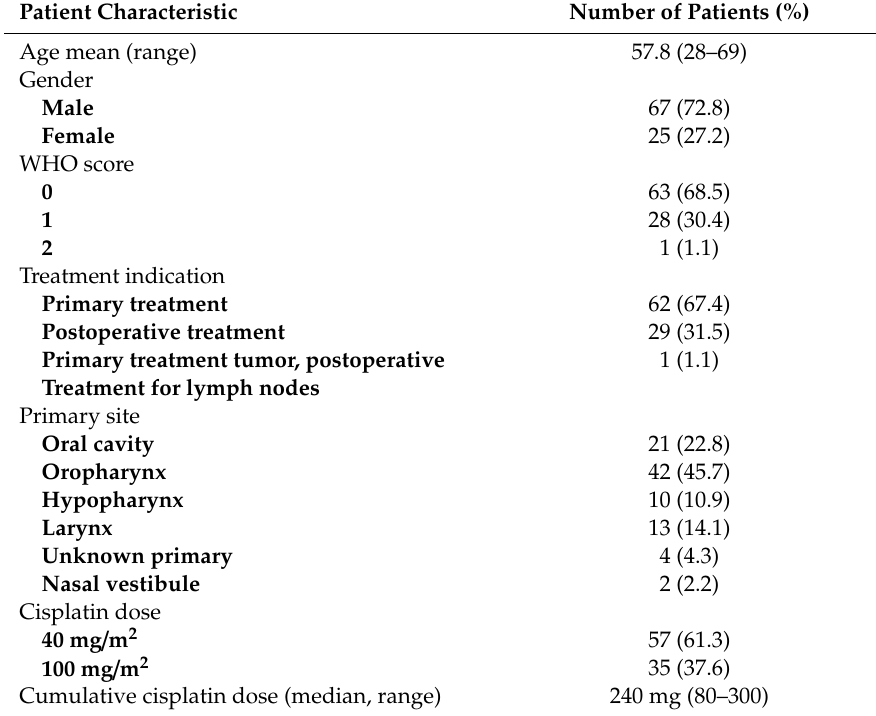
Table 1. Patient characteristics of the 92 patients analyzed. WHO: World Health